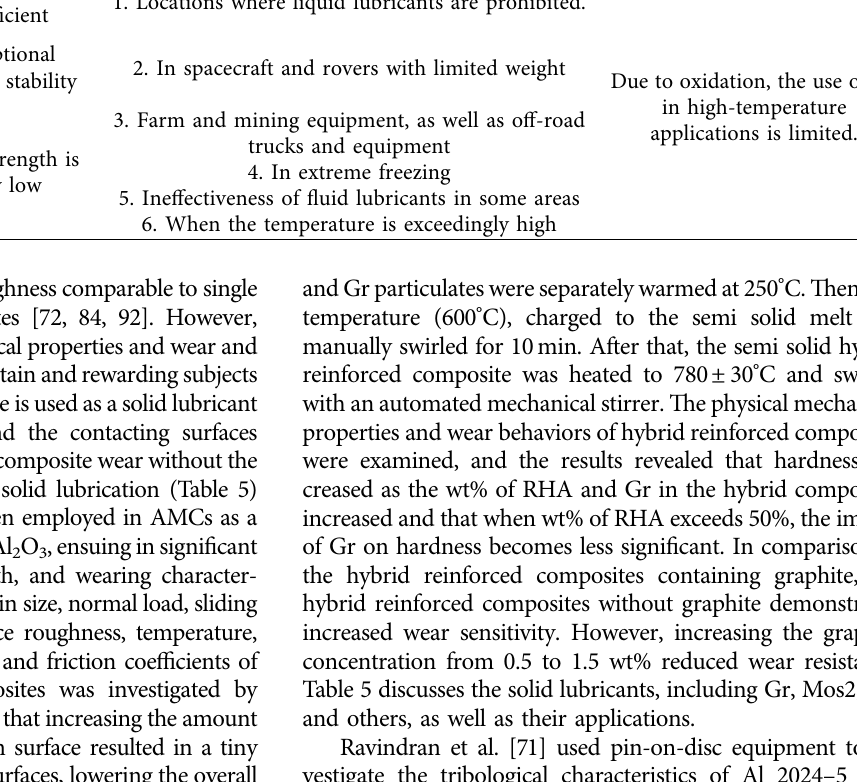
2, and soft metals such as Pb, Ag, Au, Cu) properties and application area [95, 96].